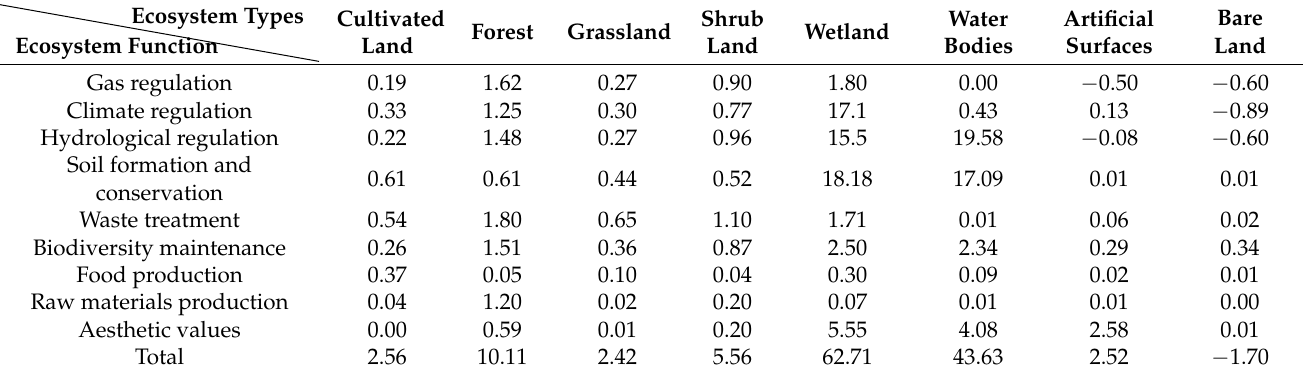
Table 3. The equivalent factor table of ESV in the main stream of the Tarim